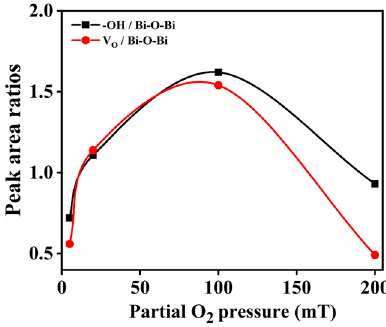
Figure 19. The variation in XPS peak area ratio with the deposition O 2 partial pressures.